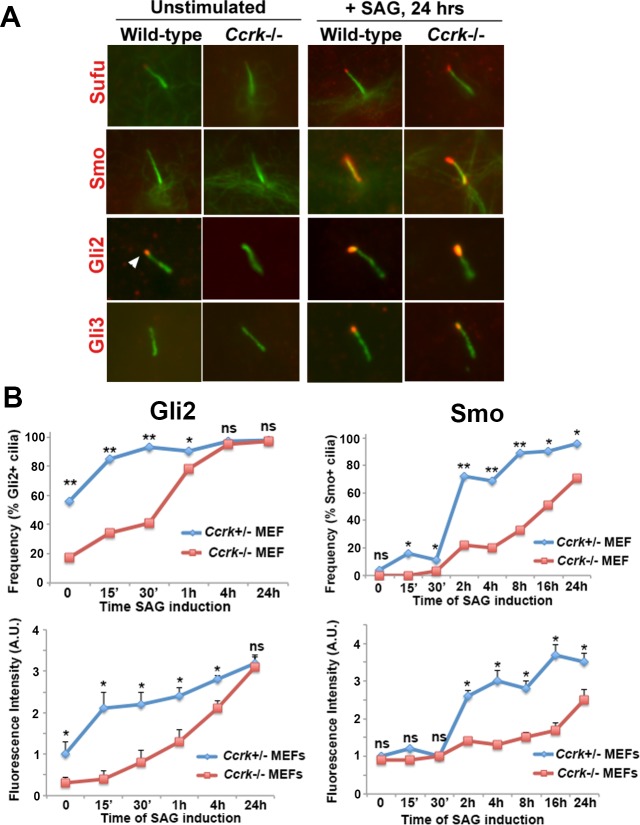
Localization of Hedgehog signaling proteins to Ccrk mutant cilia.(A) Localization of Hh pathway components to wild-type and Ccrk mutant MEFS under unstimulated or stimulated (200nM SAG for 24 hours) conditions. Note that Gli2 staining (arrowhead) was rarely observed in Ccrk mutant cilia under unstimulated conditions. (B) Ciliary localization of Gli2 and Smo was monitored in terms of frequency and staining intensity as a function of time of SAG exposure (0 to 24 hours). Percentages of cilia with Gli2 or Smo localization were determined from between 100 and 300 cilia per condition and statistical significance was analyzed using Chi-square tests. Staining intensity was measured from between 25 and 40 cilia per condition and statistical significance was analyzed using Student’s t-tests. Error bars represent standard error of the mean. P values from statistical analyses: **. P<0.01; *, p<0.05; ns, not significant.